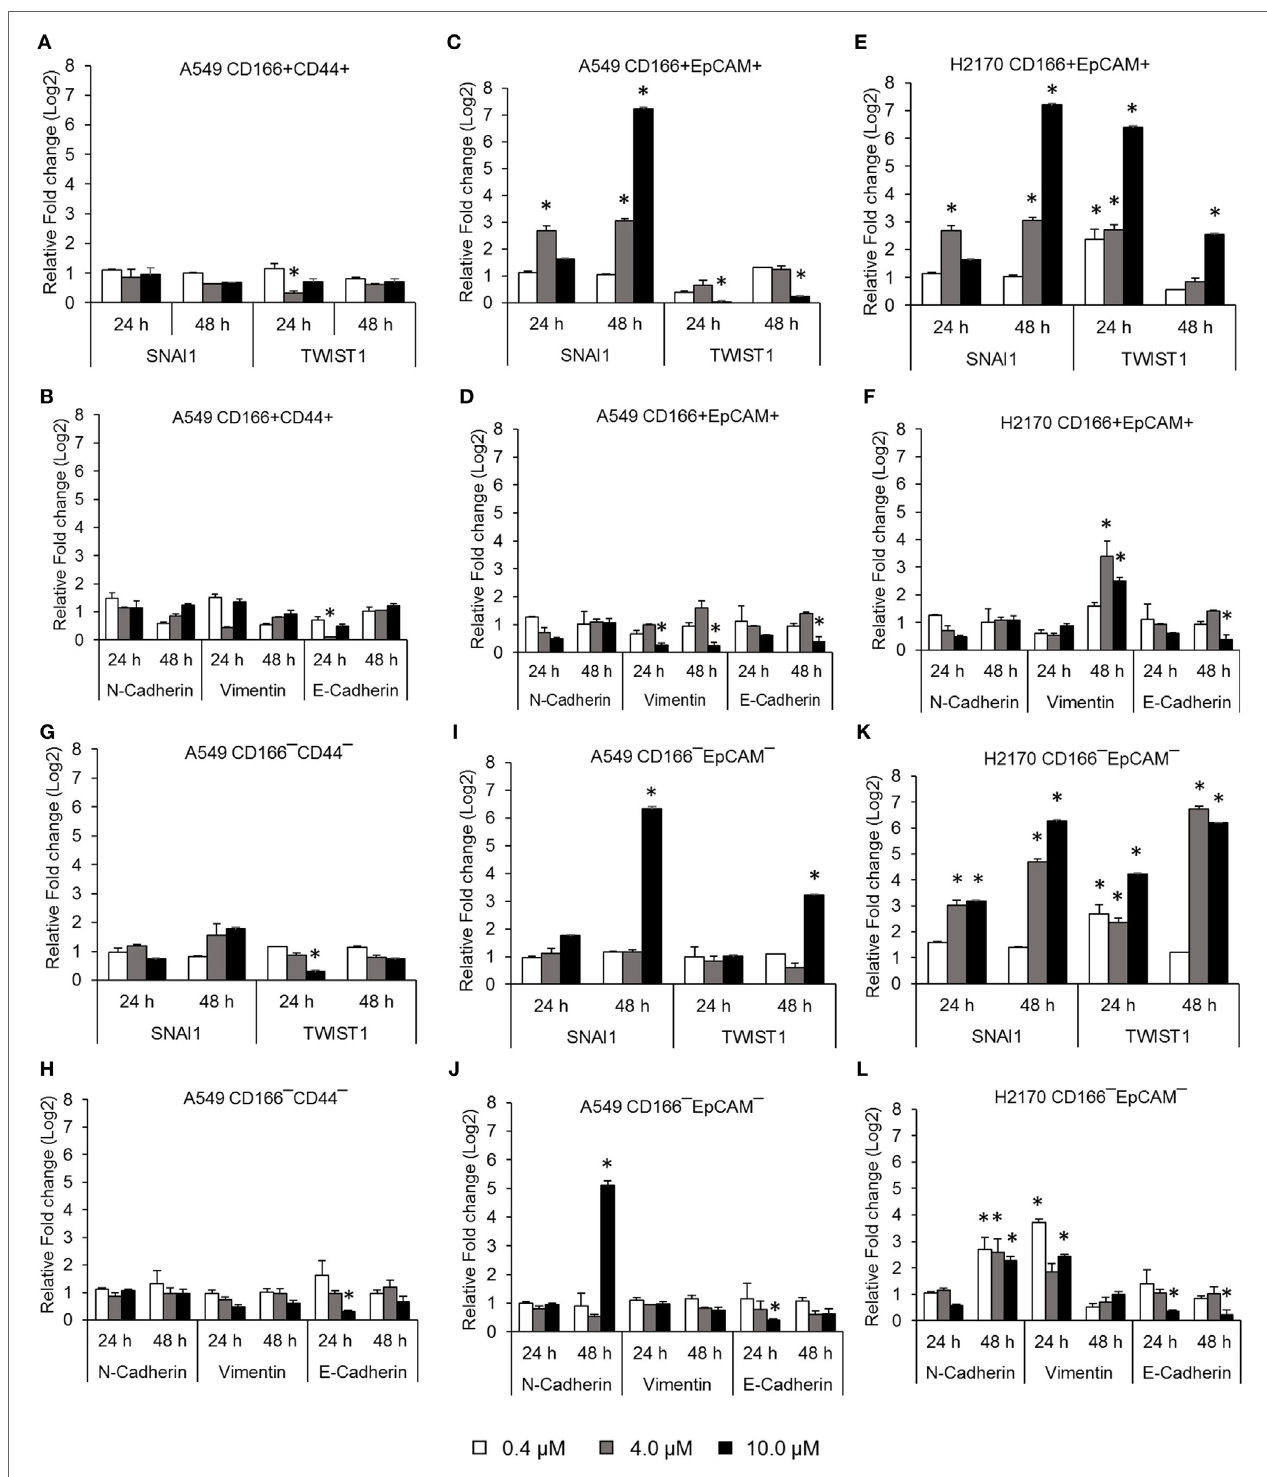
FigUre 2 | Quantitative real-time polymerase chain reaction results showing expression of genes involved in the epithelial to mesenchymal transition (EMT) process in lung cancer stem cells treated with different concentrations of BMS-345441. Relative expression of EMT switch genes ( SNAI1 and TWIST1 ), mesenchymal markers (N-cadherin and Vimentin), and the epithelial marker (E-cadherin) in (a,B) A549 CD166 + CD44 + ; (c,D) A549 CD166 + EpCAM + ; (e,F) H2170 CD166 + EpCAM + ; (g,h) A549 CD166 − CD44 − ; (i,J) A549 CD166 − EpCAM − ; and (K,l) H2170 CD166 − EpCAM − cells. The fold change was calculated using the 2 −ΔΔ ct formula, and GAPDH was used as the internal control. Graphs show fold change relative to the untreated sample. The results represent the mean ± SD of three replicates. The p -value was calculated using analysis of variance by comparing the treatment groups with the untreated group (* p < 0.05).